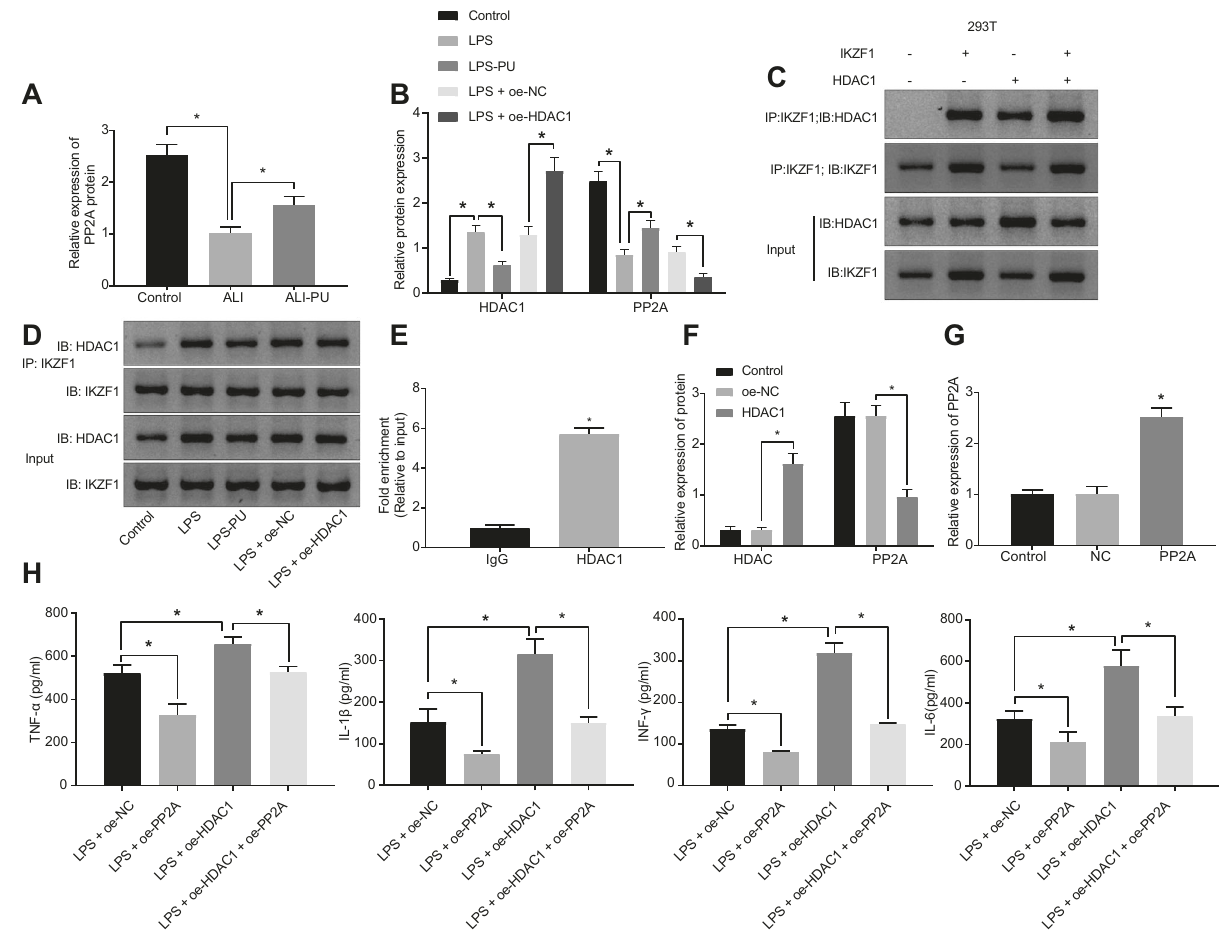
Fig. 3 HDAC1 promotes LPS-induced cell in fl ammation through PP2A. A PP2A protein expression in lung tissues of animal models assayed by western blot analysis ( n = 10). B The expression of HDAC1 and PP2A in RAW 264.7 cell models, checked by western blot analysis. C The interaction between HDAC1 and IKZF1 in 293 T cells, detected by Co-IP. D The interaction between HDAC1 and IKZF1 in RAW 264.7 cells detected by Co-IP. E The enrichment of HDAC1 in the PP2A HDAC1 bound to the promoters region, veri fi ed by ChIP. F The effect of HDAC1 on the expression of HDAC1 and PP2A in RAW 264.7 cells assessed by western blot analysis. G The effect of PP2A overexpression in RAW 264.7 cells checked by RT-qPCR. H The levels of lung in fl ammatory factors (TNF- α , IL-1 β , INF- γ and IL-6) in RAW 264.7 cell supernatant after transduction evaluated by ELISA. * p < 0.05.